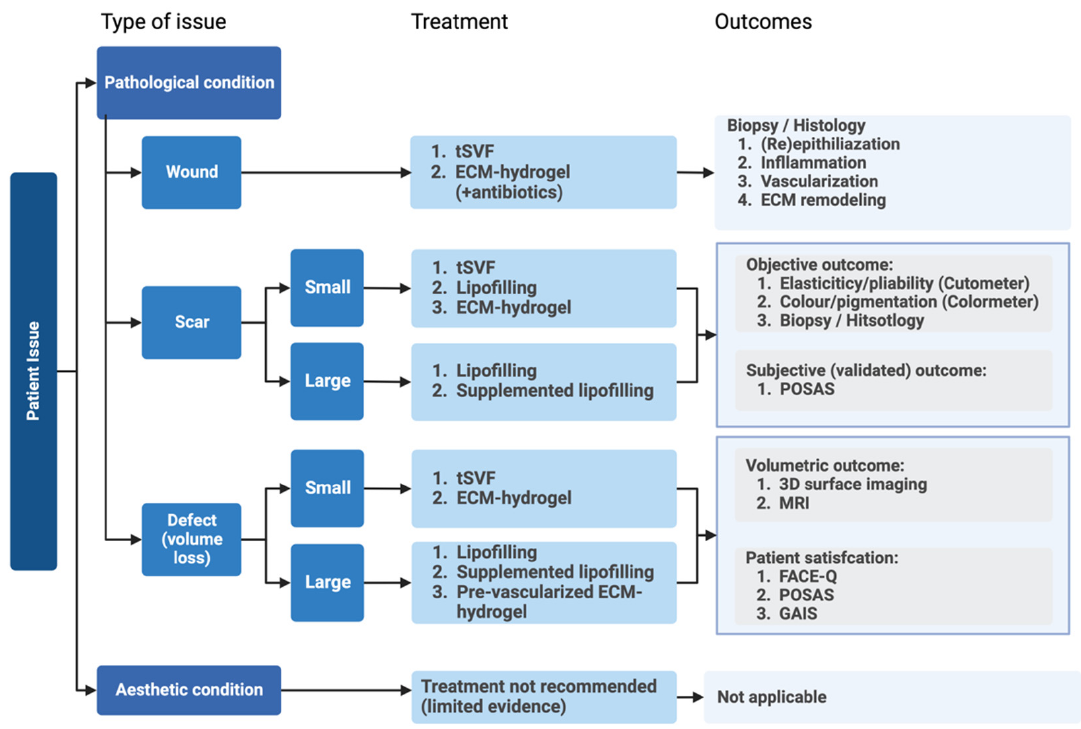
Figure 1. Overview of patient-related dermal issues and the most suitable adipose-tissue-derived treatment options and indicated outcome